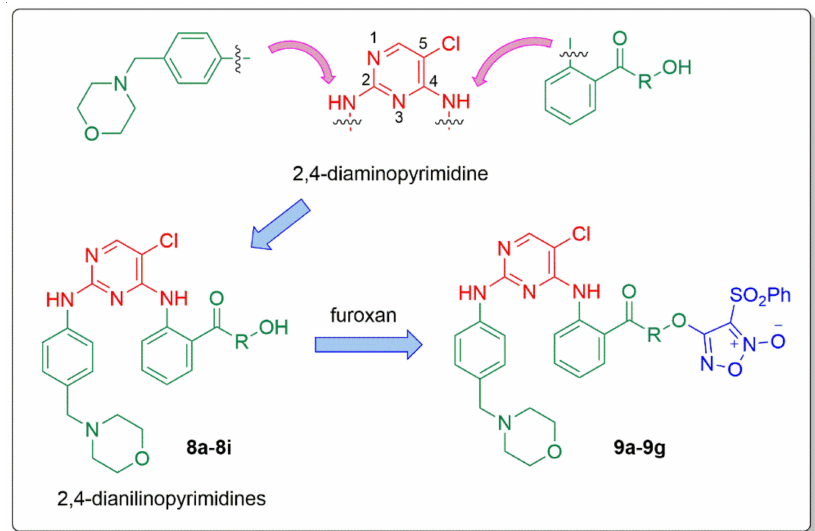
Figure 2. Design strategy of the target